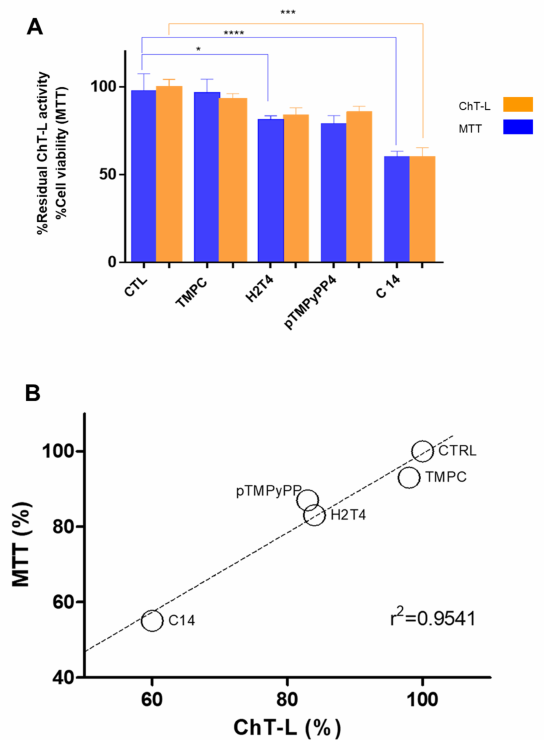
Figure 10. ( A ). Proteasome inhibition effects of different porphyrin derivatives (10 µ M) monitored by luminescent probes (ProteasomeGlo) in living MCF7 cancer cells in the dark. Orange bars represent the residual ChT-L activity. Blue bars represent the cell viability of MCF7 cells treated with the same amount of inhibitor. Data from three independent experiments were normalized to untreated controls and are reported as mean ± standard deviation. Analysis of variance has been performed by one-way ANOVA followed by statistical Sidak’s test (* p < 0.05; *** p < 0.01; **** p < 0.0001). The relationship existing between proteasome inhibition and pro-apoptotic potential is supported by ( B ), which reports a linear fit of the residual ChT-L proteasome activity in living cells, plotted versus the cell viability detected by